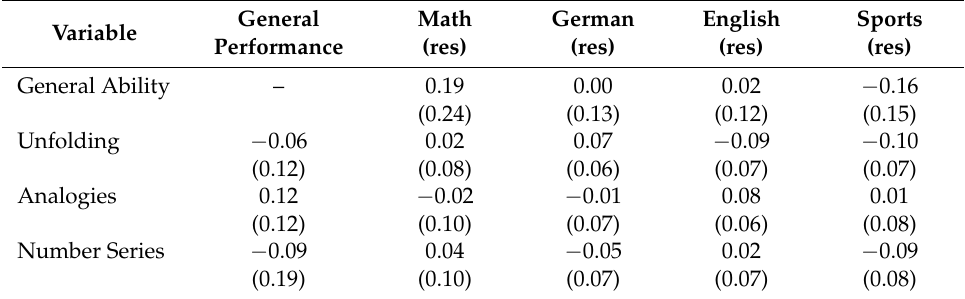
Table 2. Standardized relationship between cognitive abilities and academic performance. General Variable General